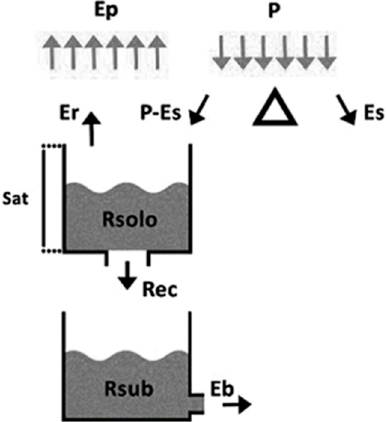
. In this sub and C es rec